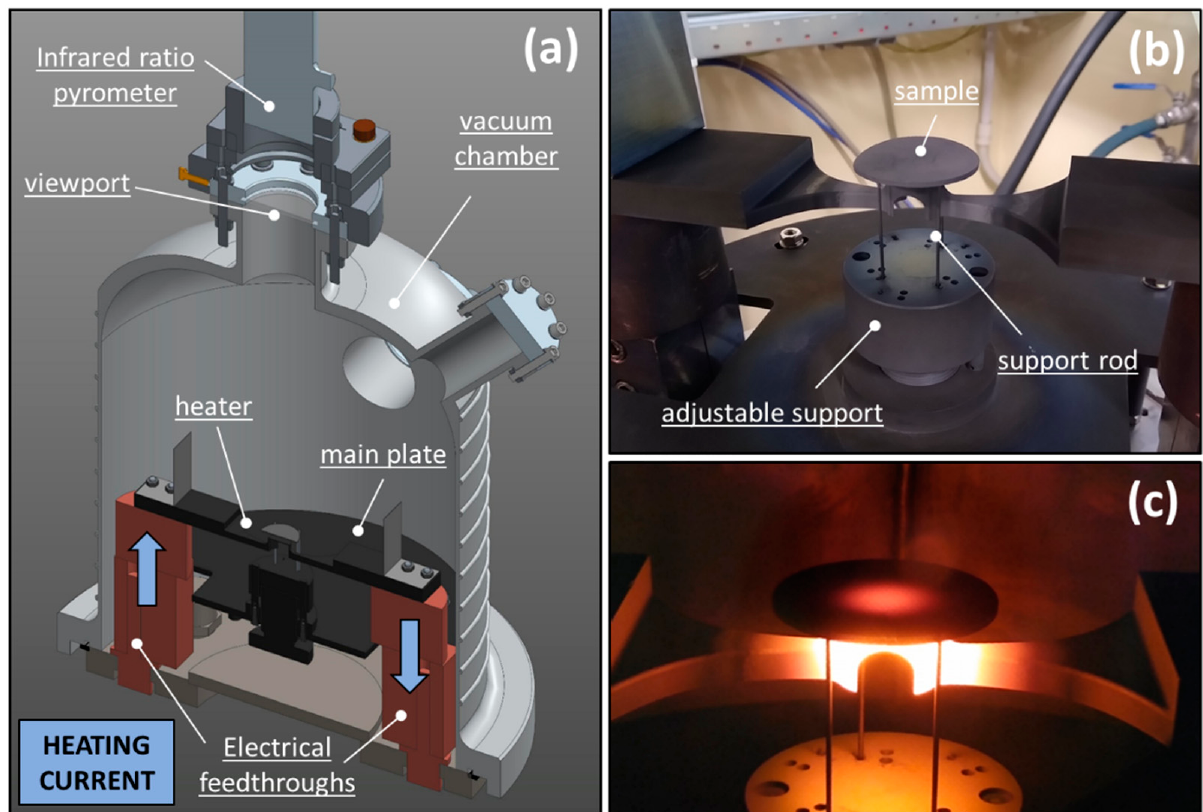
Figure 1. The experimental test bench adopted for the measurement of the sample emissivity and temperature data necessary for the thermal conductivity estimation: general CAD view ( a ), detailed view of the sample and heater ( b ), and pictures of the components at high temperature during a test with a TiC specimen ( c ).